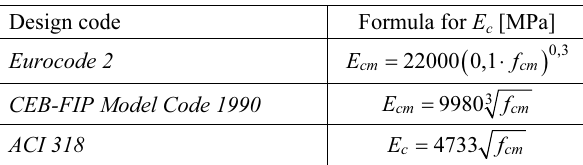
Table 1. Formulas for the modulus of elasticity at age of 28 days Design